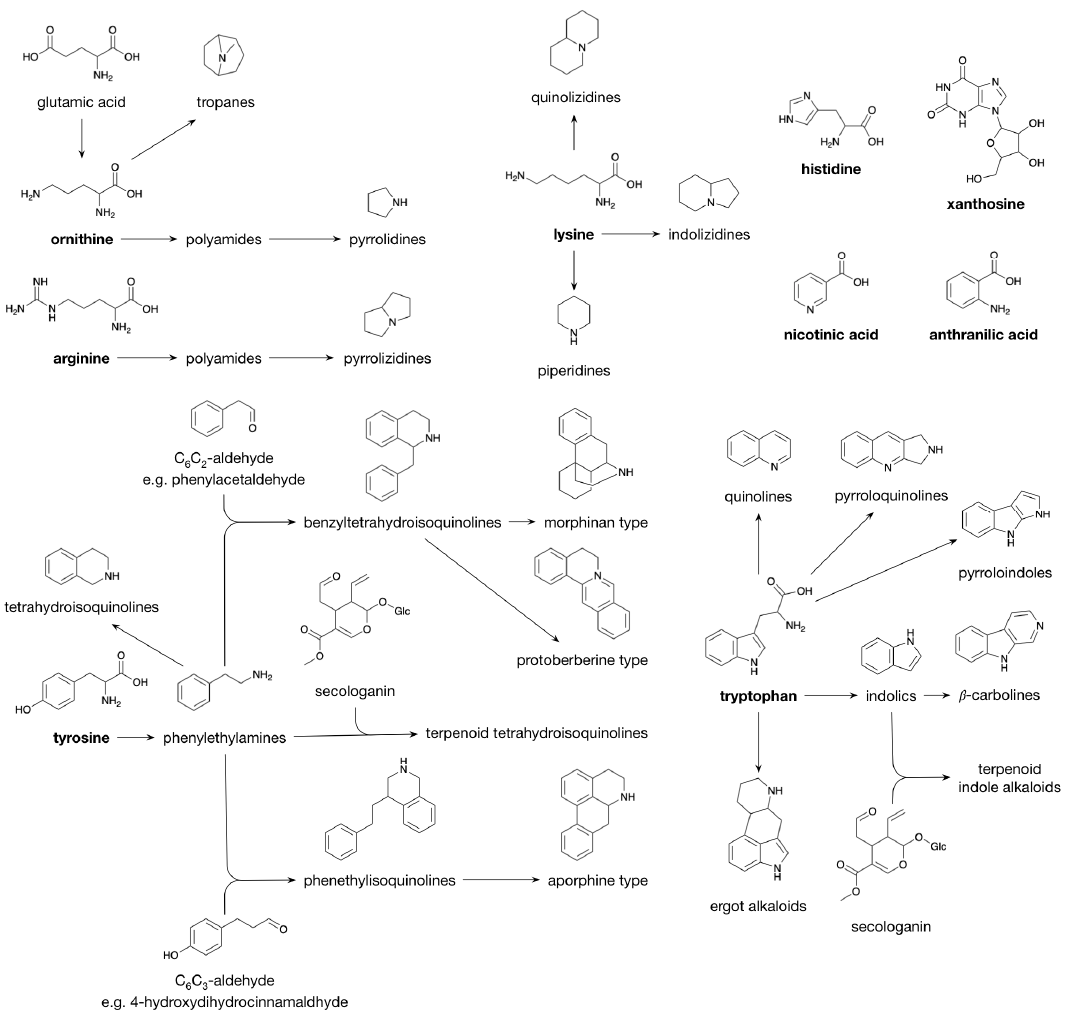
Figure 3. Biosynthesis of Alkaloids.